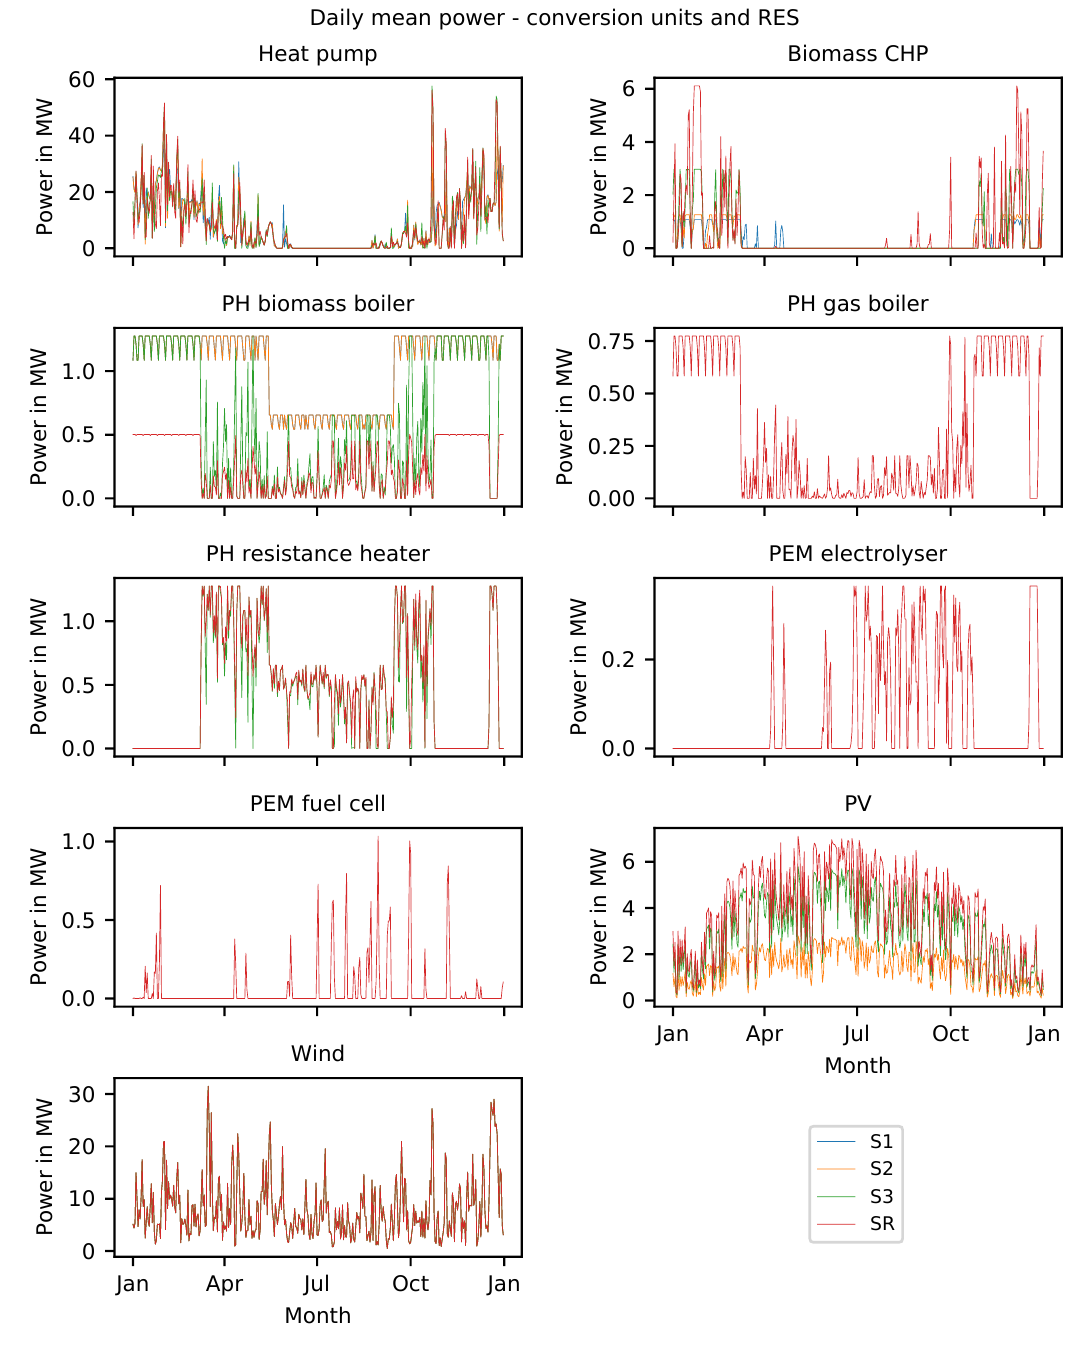
Figure 7. Daily mean power of the conversion units and RES. (Source: own representation). The more different conversion units available, the lower the capacity factors (Table 9), which are calculated according to Equation (19). Exceptions are small scale units with dedicated base-load operation, for example, the process heat biomass boiler in SR. Because of the major seasonal component of domestic heat and hot water demand, the capacity factors for the production units are restricted by the shape of the load profile. The same applies for the electrolyser and the fuel cell. They are part of the long term H 2 storage and only one can operate at a